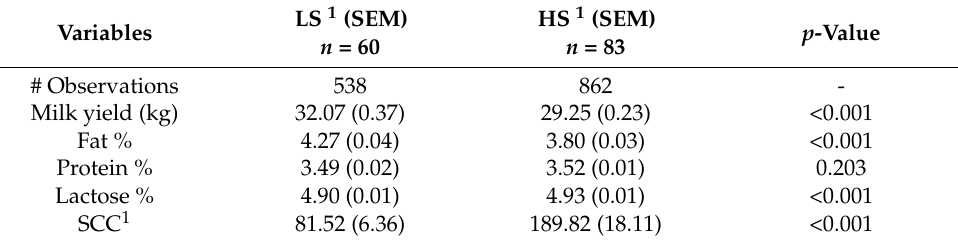
Table 2. Mean values of milk data from functional controls grouped by SCC 1 classification (i.e., LS 1 and HS 1 ). Differences were statistically tested through t -test (SEM and p -value are reported, where